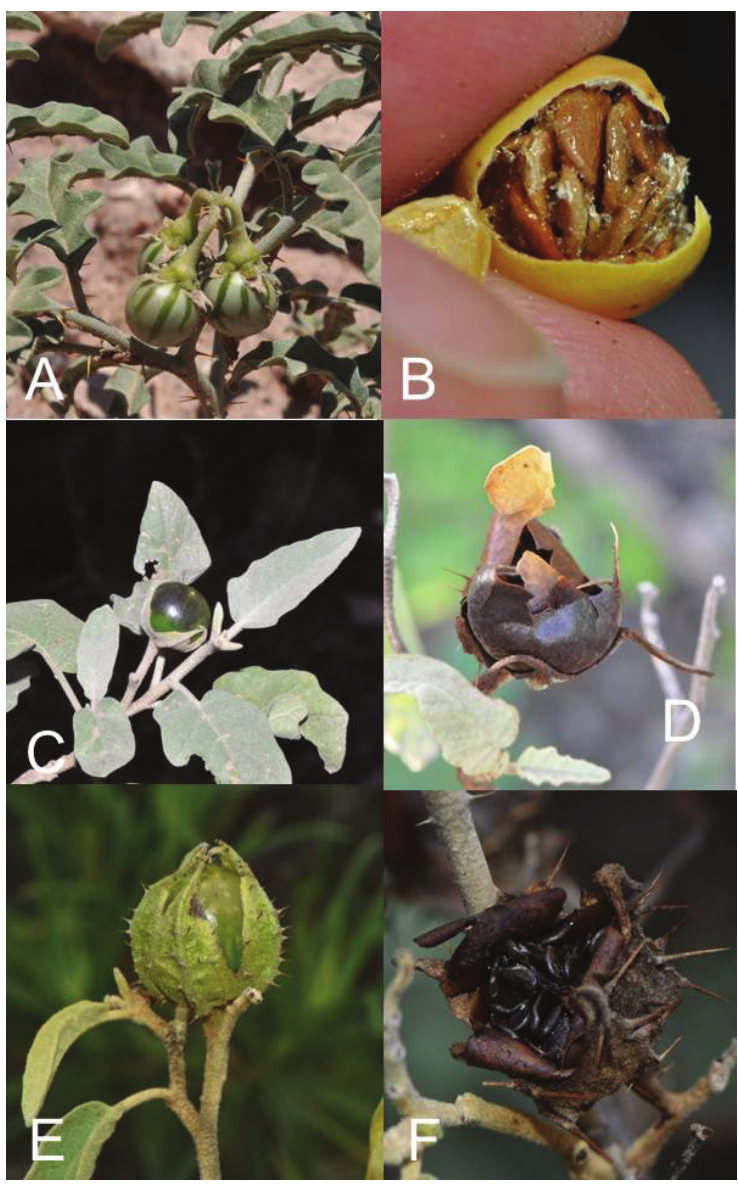
Figure 3. Fruits of members of the Elaeagnifolium clade. A Solanum elaeagnifolium , immature berries with green mottling (Argentina, Córdoba, Barboza et al. 3434 ) B Solanum elaeagnifolium , mature fruit with sticky tan seeds (Argentina, Córdoba, Barboza et al. 3435 ) C Solanum mortonii , immature fruit exerted from the calyx (Argentina, Catamarca, Barboza et al. 3439 ) D Solanum mortonii , mature fruit exerted from the calyx (Argentina, Catamarca, Barboza et al. 3438 ) E Solanum houstonii , immature fruit enclosed in accrescent calyx (Mexico, Querétero, Ochoterena et al. 976 ) F Solanum houstonii , mature fruit enclosed in accrescent calyx with black seeds (Mexico, Querétero, Ochoterena et al. 976 ). Photographs by S.